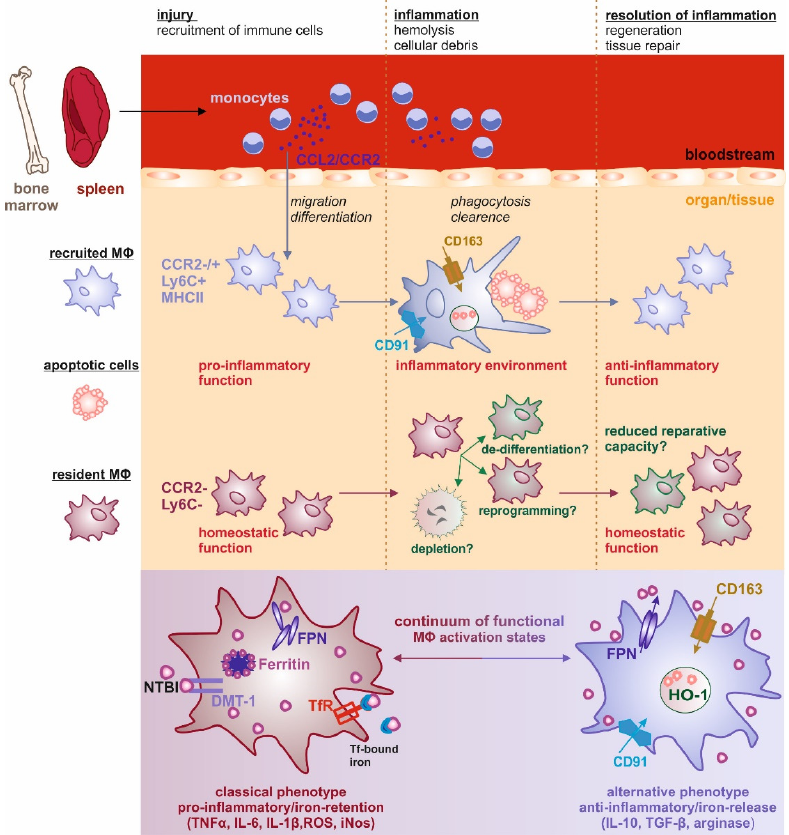
Figure 1. Hypothetical scheme of M Φ iron polarization during injury and recovery. Different M Φ subpopulations have been described with varying levels of lymphocyte antigen 6 (Ly6C) and major histocompatibility complex (MHCII). Under physiological conditions, resident M Φ predominate to- gether with embryonic progenitors that are not replenished by circulating monocytes under steady- state conditions. Resident M Φ in the healthy state promote tissue homeostasis. CCR2 + M Φ are re- plenished by blood monocyte recruitment and local proliferation, whereas CCR2 - M Φ are repopu- lated by local proliferation. Infiltrating pro-inflammatory monocyte-derived M Φ (Ly6C + CCR2 − and Ly6C + CCR2 + ) promote tissue injury and death by substitution of the resident M Φ subpopulation. Shown is a continuum of functional activation states, with two extreme phenotypes linked to the highly diverse M Φ functional activation states in the different stages of inflammation and resolution of inflammation. The iron phenotype is also closely related to the M Φ polarization profile, with its two extremes of iron retention and iron release. Author Contributions: Writing—original draft preparation, C.M., O.M., N.K.H., M.S., M.U.M., M.J.; writing—review and editing, C.M., O.M., N.K.H., M.S., M.U.M., M.J.; visualization, C.M.; supervi- sion, M.J.; project administration, M.J.; funding acquisition, M.J. All authors have read and agreed to the published version of the manuscript. Funding: This research was funded by Wilhelm Sander-Stiftung (2017.130.2, awarded to MJ). OM was supported by a Junior Research Grant from the European Hematology Association OM (EHA: RG-70). Institutional Review Board Statement: Informed Consent Statement: Data Availability Statement: